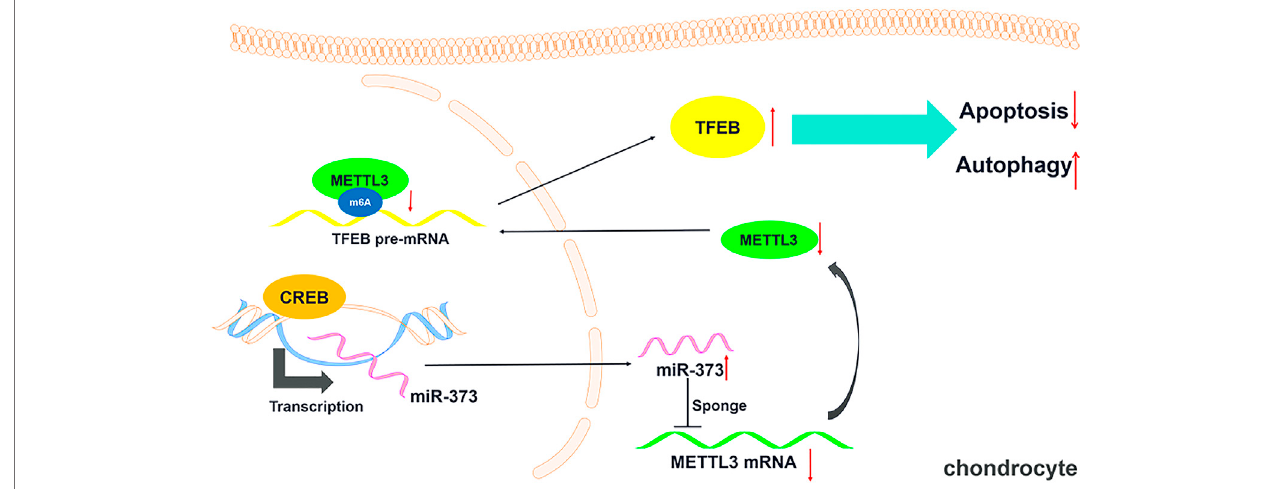
FIGURE 6 | Schematic diagram of this study. A schematic model showing that CREB regulating chondrocytes autophagy/apoptosis via the miR-373/METTL3/ TFEB axis.